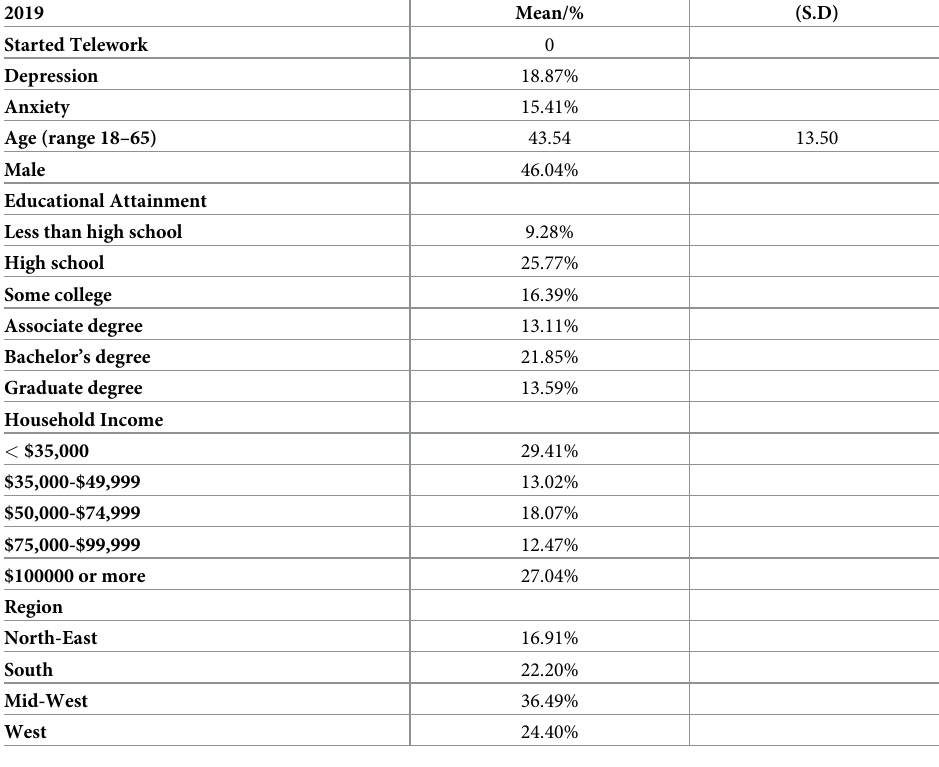
Table 2. 2019 national health interview survey